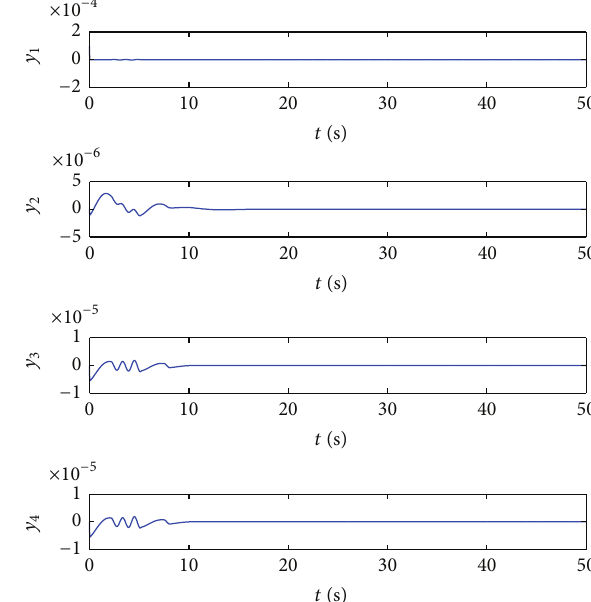
Figure 7: Time-domain waveforms.